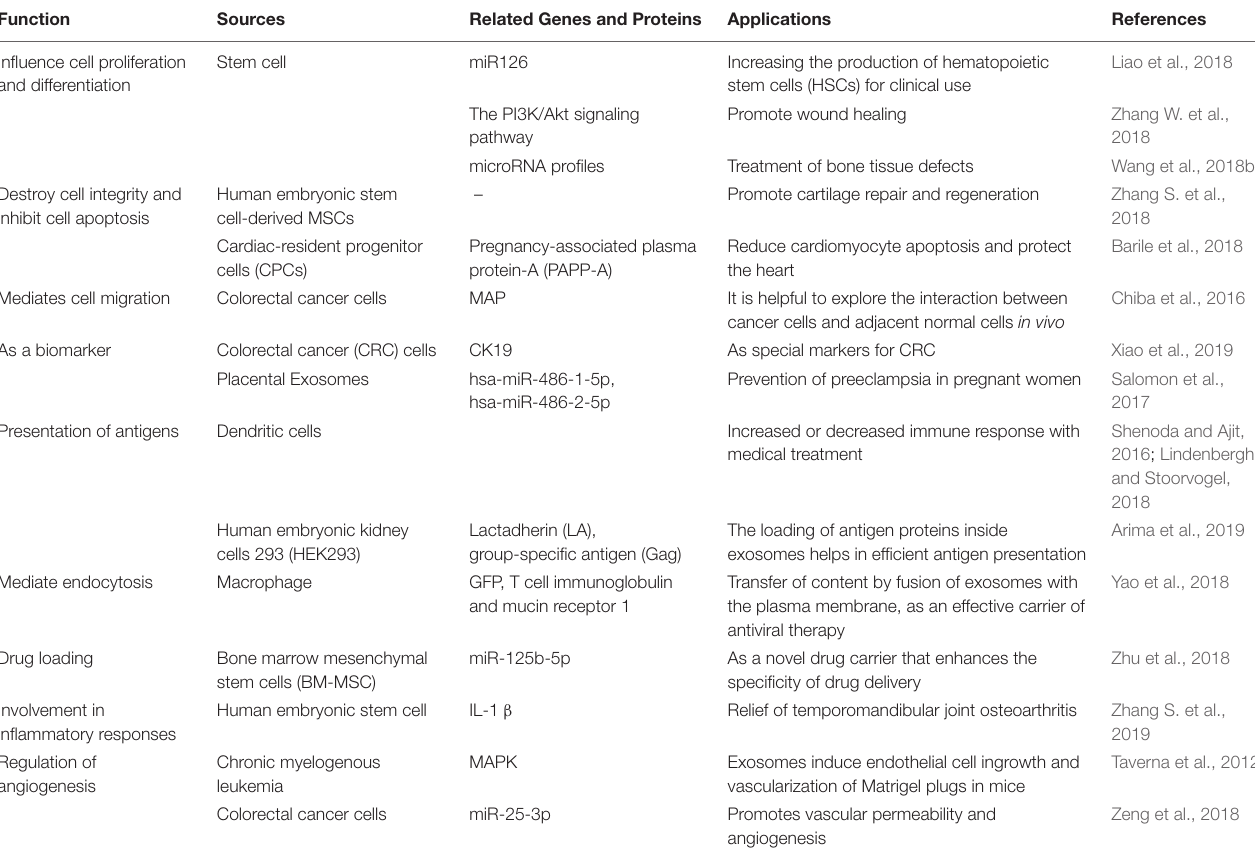
TABLE 3 | The sources and functions of